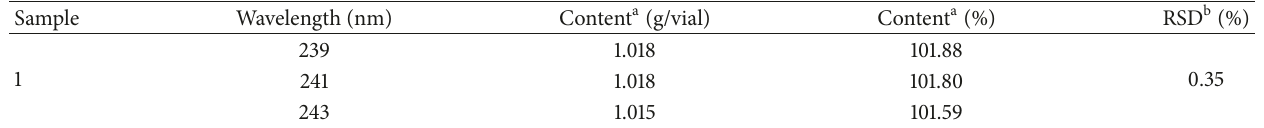
Table 3: Results of the evaluation of the robustness of the analytical method by UV spectrophotometry.